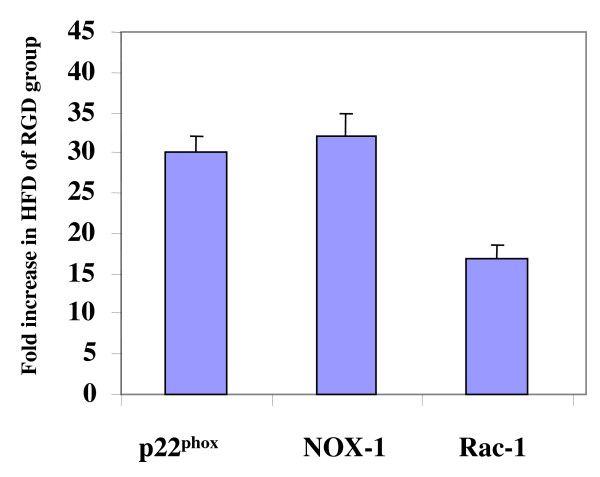
Quantitative mRNA expression of NADPH oxidase components (p22phox, NOX-1 and Rac-1) in aortic tissues from p21-/- mice. The results of mRNA expression of NADPH oxidase components; p22phox, NOX-1 and Rac-1 are shown as fold increase in high fat diet (HFD) treated p21-/- mice (n = 8) using results from regular diet (n = 8) treated mice as controls (RGD).